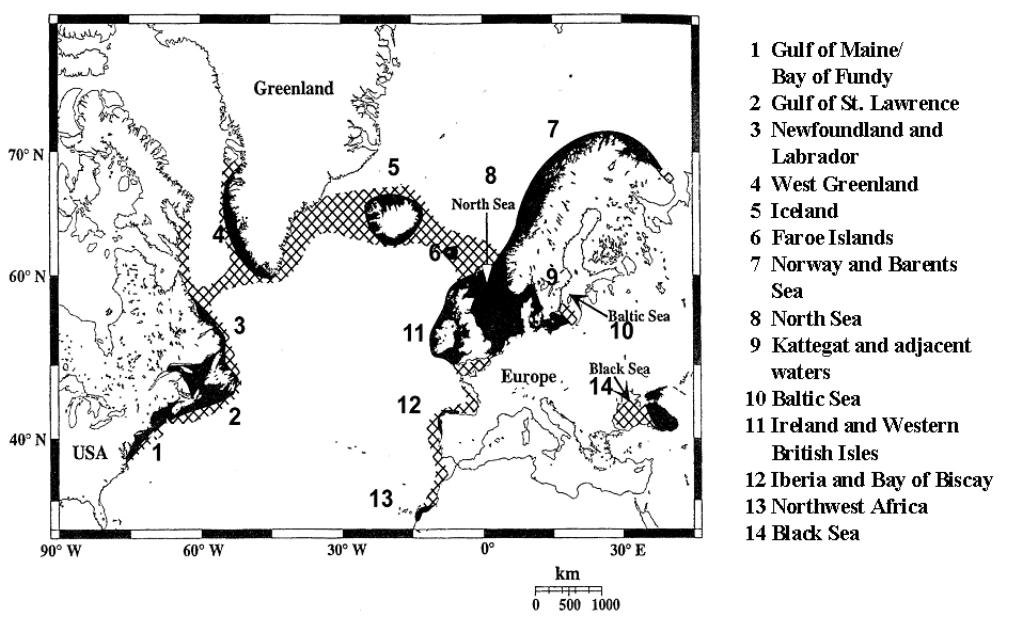
Fig. 1 . Revision of Gaskin's (1984) harbour porpoise population divisions - after IWC